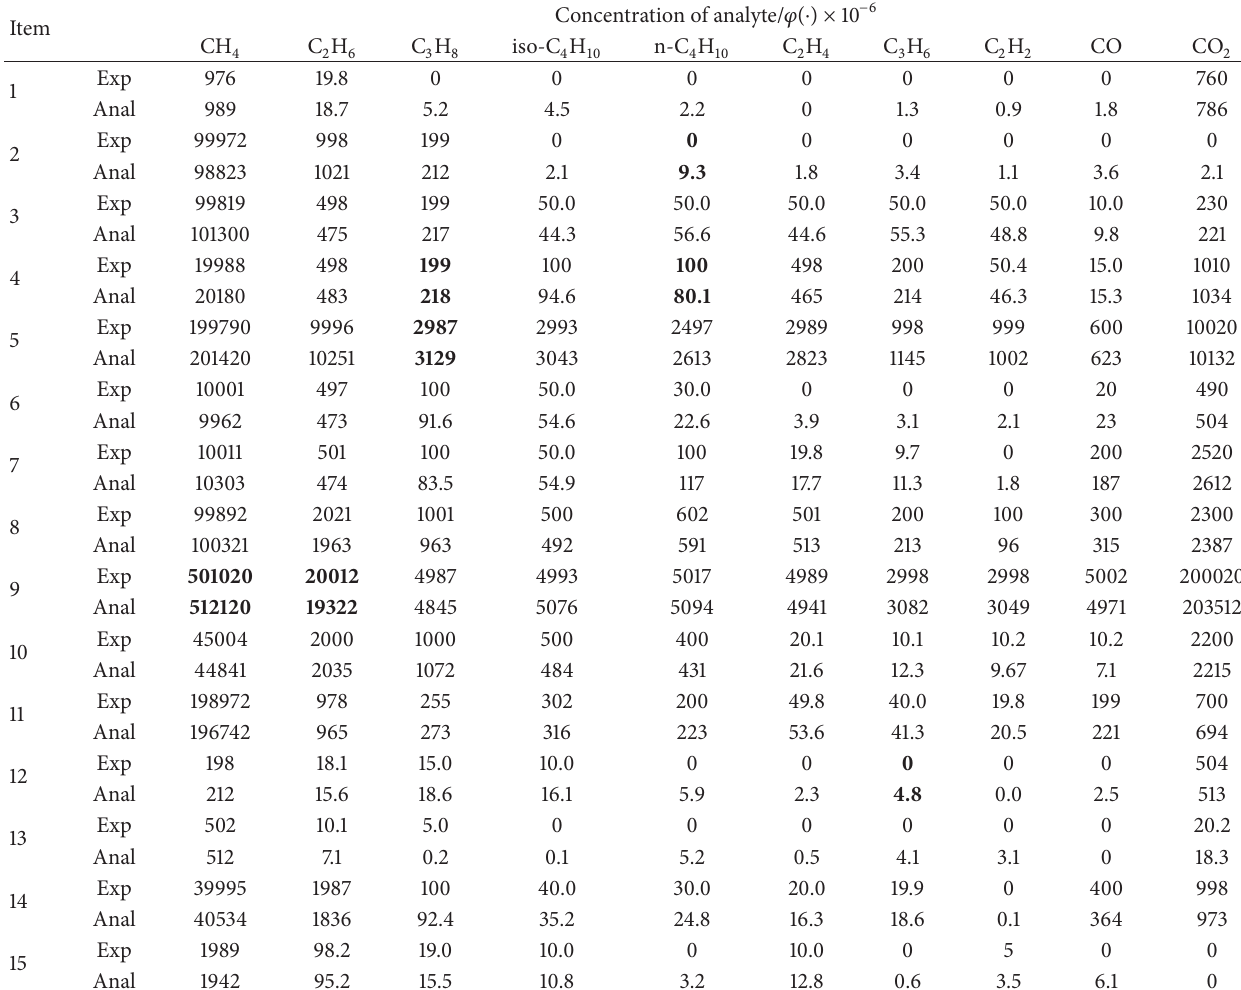
Table 3: Testing results with standard gas mixture.